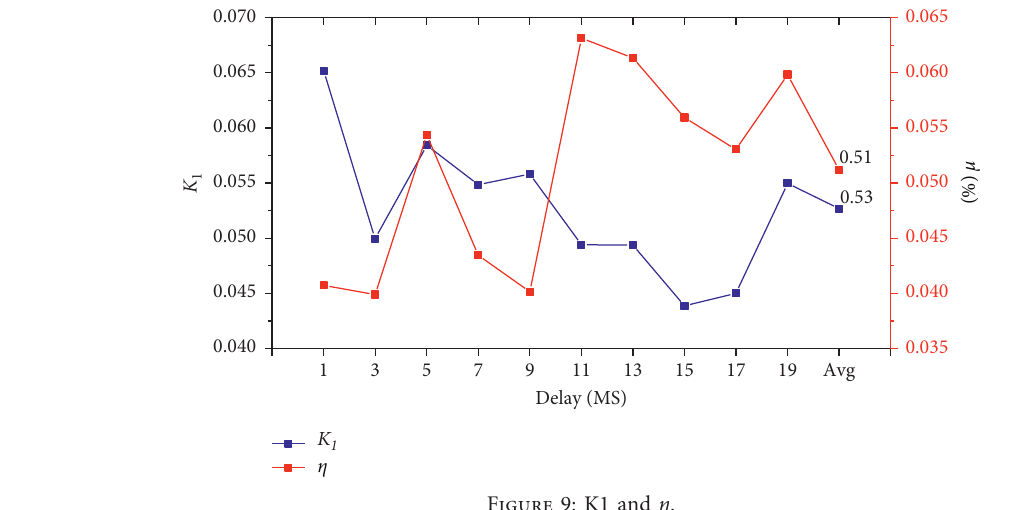
Figure 9: K1 and η .